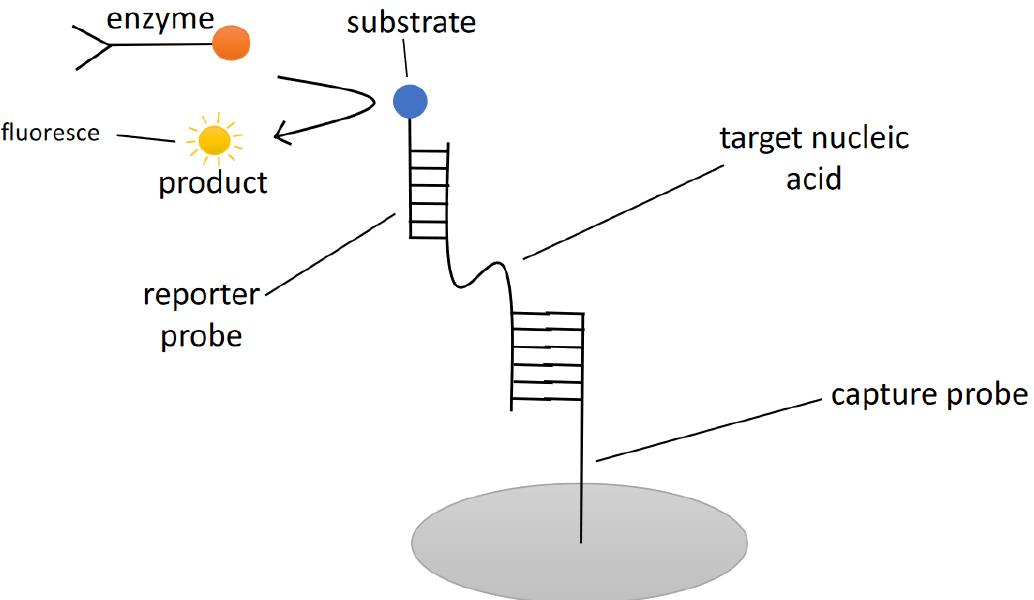
Figure 5. An example of enzyme-linked immunosorbent assay (ELISA) concept. A sandwich hybridization concept with a measurable output based on fluorescence.